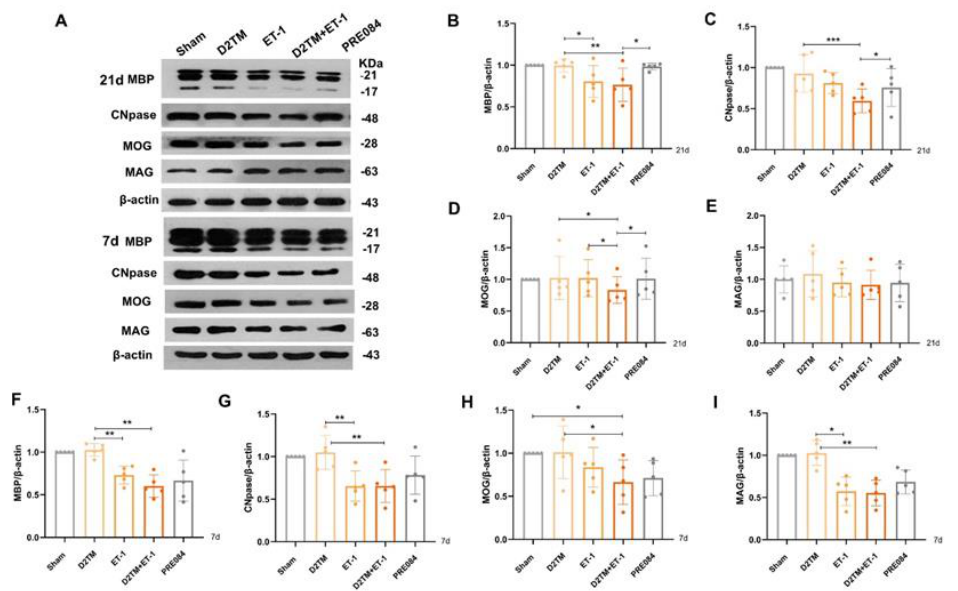
Figure 4. PRE084 promoted mature oligodendrogenesis and myelin regeneration in diabetic mice with stroke. ( A ) An immunoblot analysis of the hippocampus with antibodies against MBP, CNpase, MOG, and MAG at 21 and 7 d after ET-1 injection. ( B – E ) Quantification of the band densities of MBP, CNpase, MOG, and MAG at 21 d after ET-1 injection. ( F – I ) Quantification of the band densities of MBP, CNpase, MOG, and MAG at 7 d after ET-1 injection. Data are expressed as mean ± SEM; n = 5/group. * p < 0.05, ** p < 0.01, *** p < 0.001.